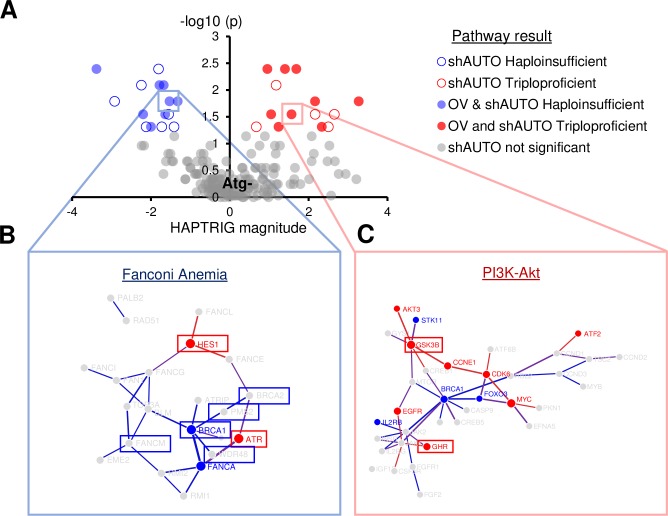
CNA patterns affect SOC pathways.A, HAPTRIG pathway analysis of SKOV3 copy-number alterations. Nominally significant (P < 0.05) pathways enriched for suppression or elevation of CNAs in SKOV3 autophagy suppressed cells (shBECN1 and shLC3B combined, “shAUTO”) by the gene-set analysis tool HAPTRIG are displayed as red (elevated) or blue (suppressed). Open colored circles indicate pathways only found in SKOV3 cells, and closed colored circles indicate pathways also found to be similarly dysregulated in TCGA studied serous ovarian cancer primary tumors (OV). B-C, Select altered pathways from TCGA serous ovarian cancer data are highlighted and networks were graphed by HAPTRIG. Scores were tabulated and those gene nodes with scores one z-score away from the median node score are displayed with blue if suppressed and in red if elevated. Edges indicate physical interactions as found in BioGrid. Boxes were drawn around genes if HAPTRIG found this node to be one of the top five influential genes (suppression and elevation were separately tested) within the selected pathway for both the SKOV3 experiment and TCGA ovarian cancers.